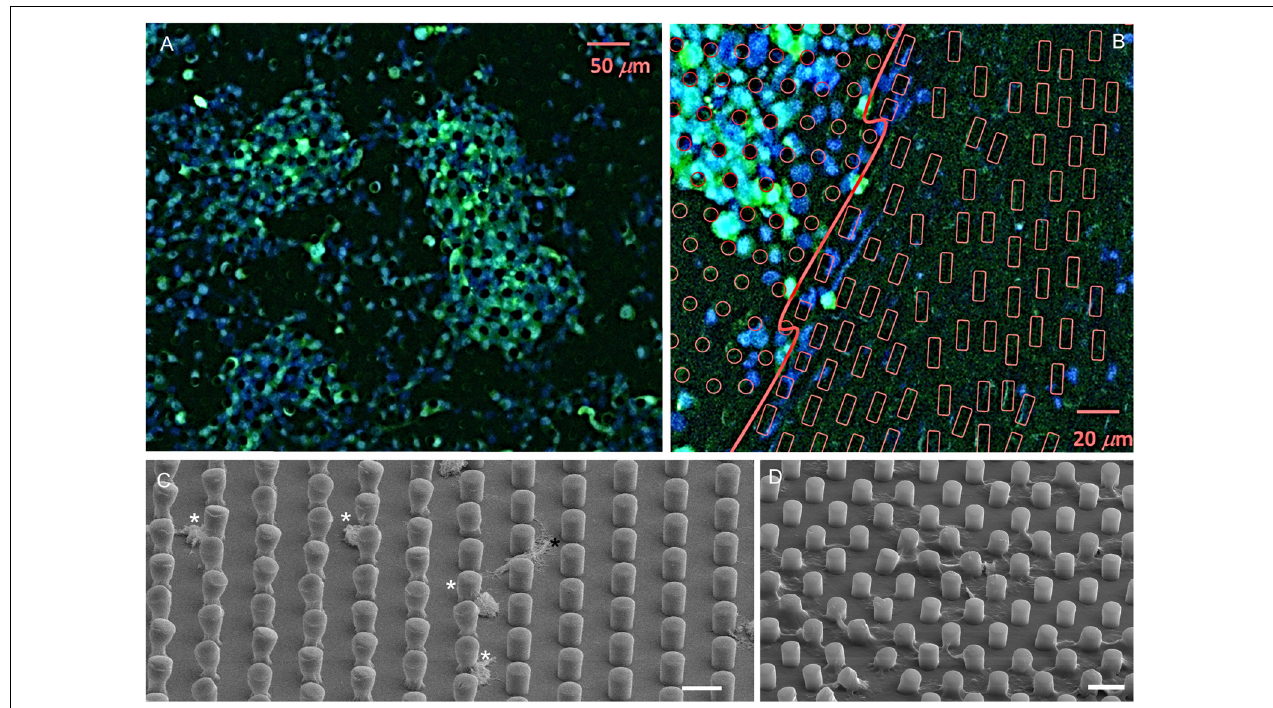
FIGURE 6 | Fluorescence microscope images, low magnification (A) and high magnification (B) , of GFP-HS-5 cells cultured on a PCL scaffold. In B, regular pillars are evidenced with red circles while deformed ones with red rectangle. SEM images of GFP-HS-5 (C) and THP-1 (D) cells grown on PCL scaffolds presenting both areas with regular and deformed micropillars; scale bars 20 µ m. White asterisks: dead cells; black asterisk: healthy